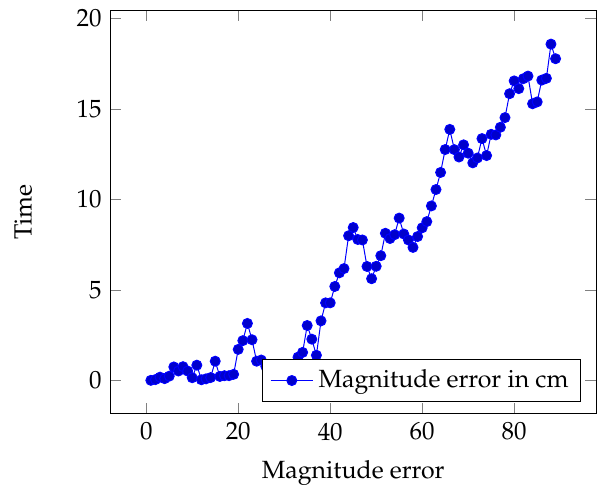
Figure 24. Data showing error over time for 3D